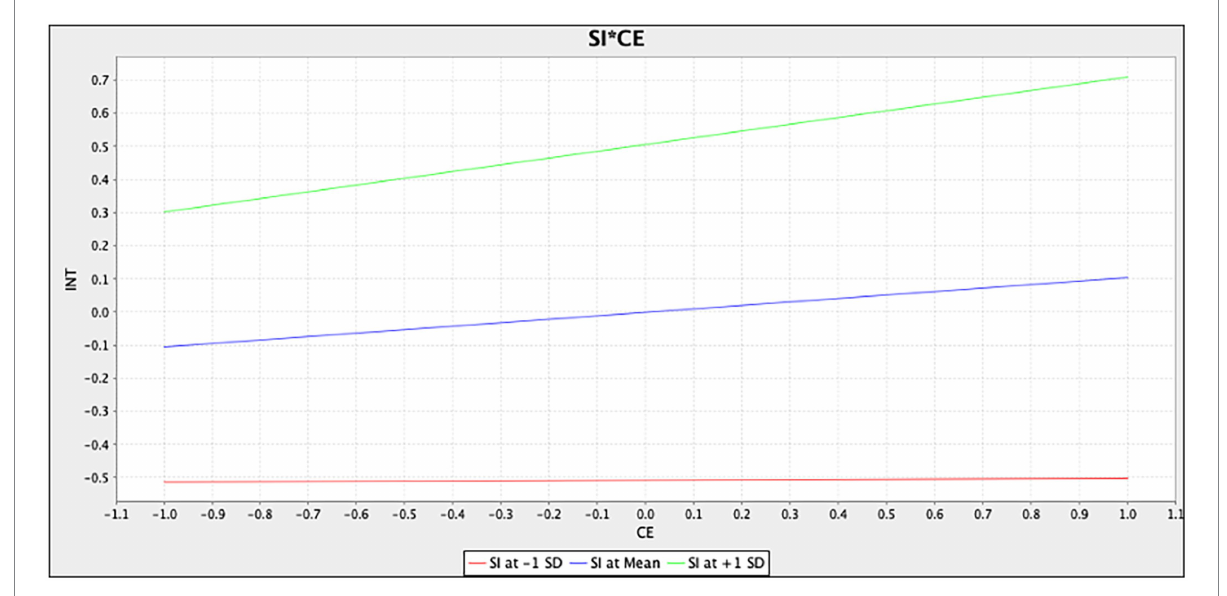
FIGURE 3 Moderating effect of situational involvement on the relationship cognitive experience and behavioral intention.